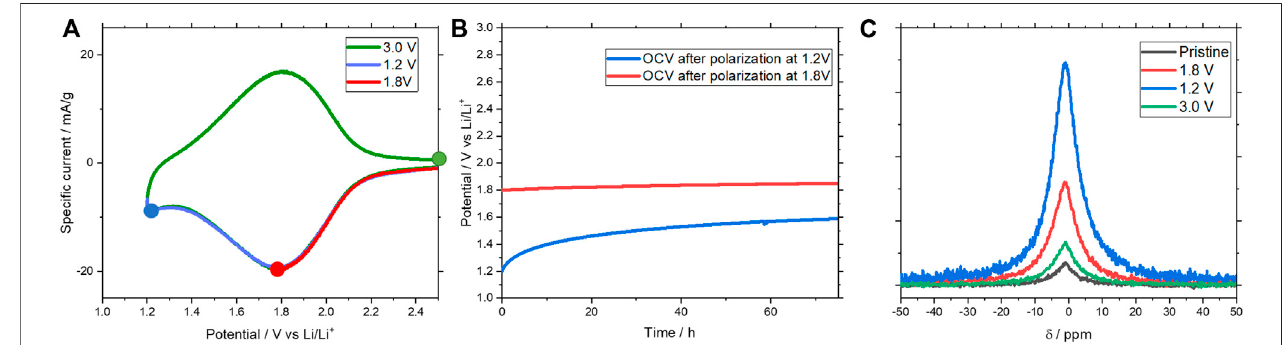
FIGURE 7 | (A) CV, (B) Self-discharge curves and (C) ex situ Li 7 MAS NMR normalized spectrum of the Ag 0.70 La 0.10 □ 0.20 NbO 3 at different state of charge/ discharge with associated